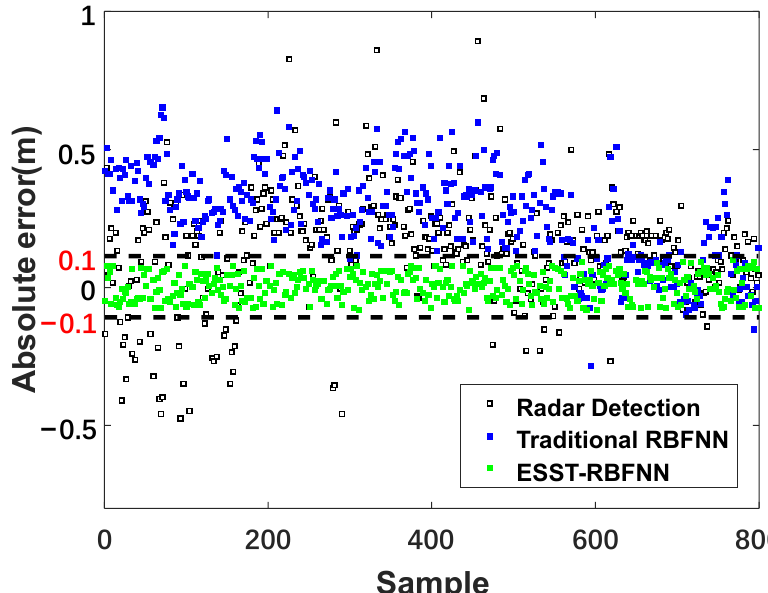
Figure 11. Compassion diagram of absolute error.